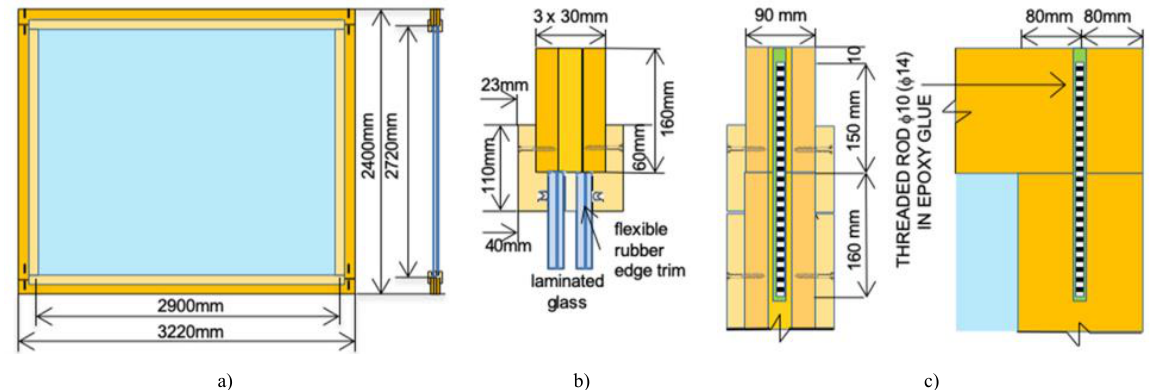
Fig. 7 Full-scale CLT-glass facade element (figure reproduced from (Žarnić et al., 2020) with permission from Elsevier): a) front view, b) glass- to-CLT frame connection detail (cross-section) and c) timber corner